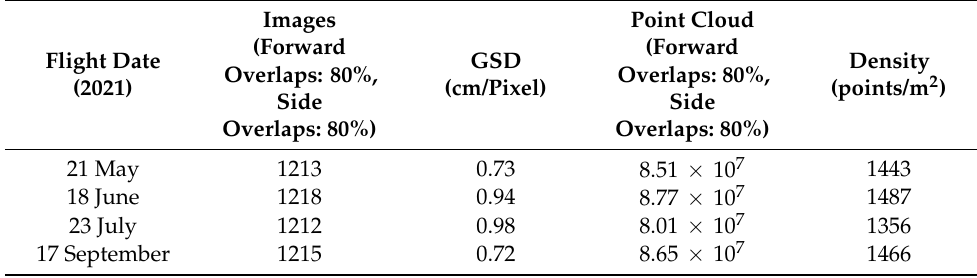
Table 2. Overview of captured images and LiDAR point